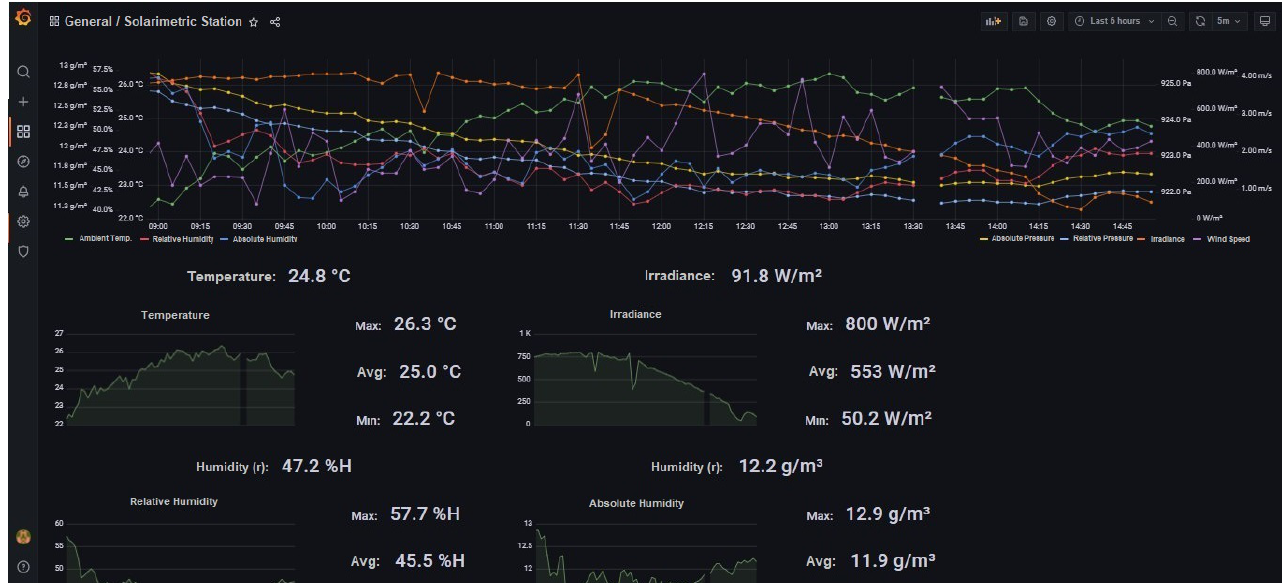
Figure 16. New supervisory system’s main screen: PV plant overview.